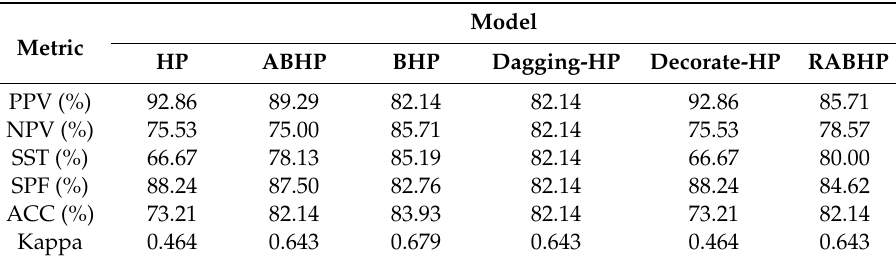
Table 3. Model performance over the validation